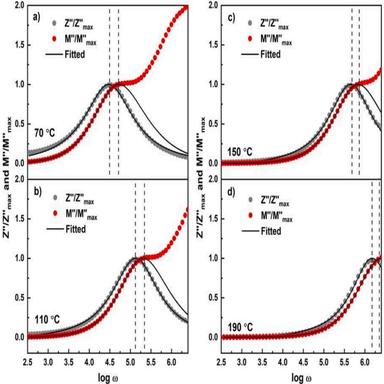
The normalized plots of Z''/Z''max and M''/M''max with frequency-dependent at a) 70 ◦C, b) 110 ◦C, c) 150 ◦C and d) 190 ◦C.